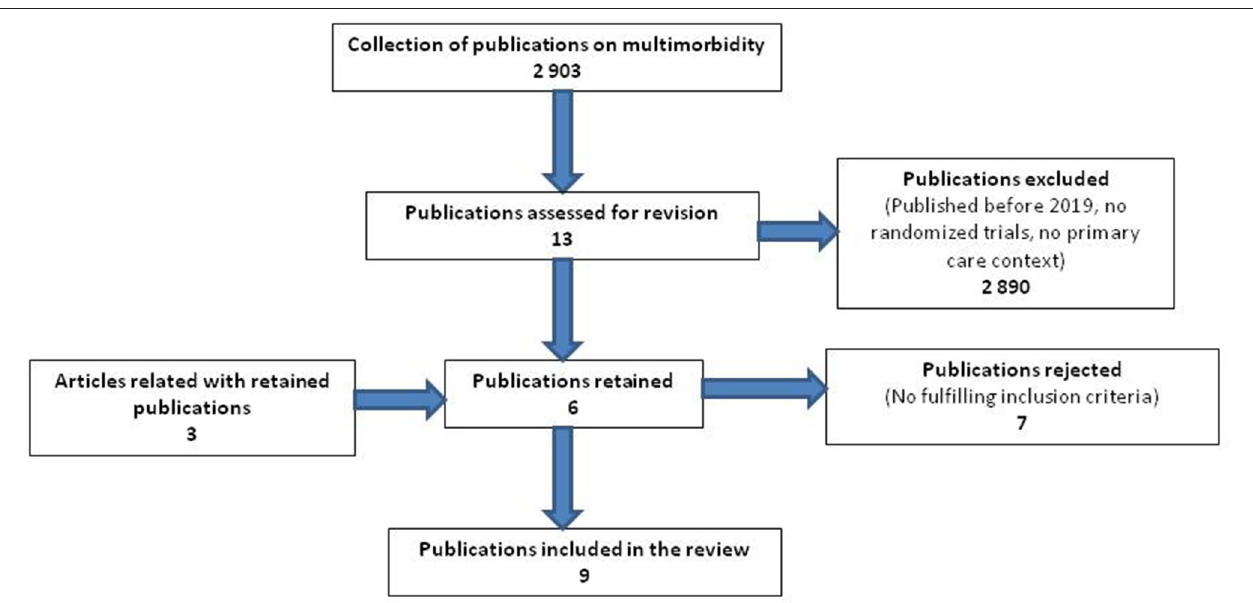
FIGURE 1 | Flow diagram for the selection of